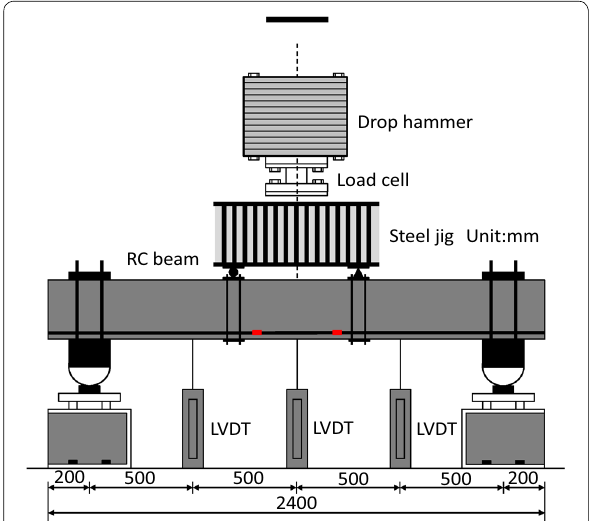
Fig. 2 Test setup (mm, 1 mm